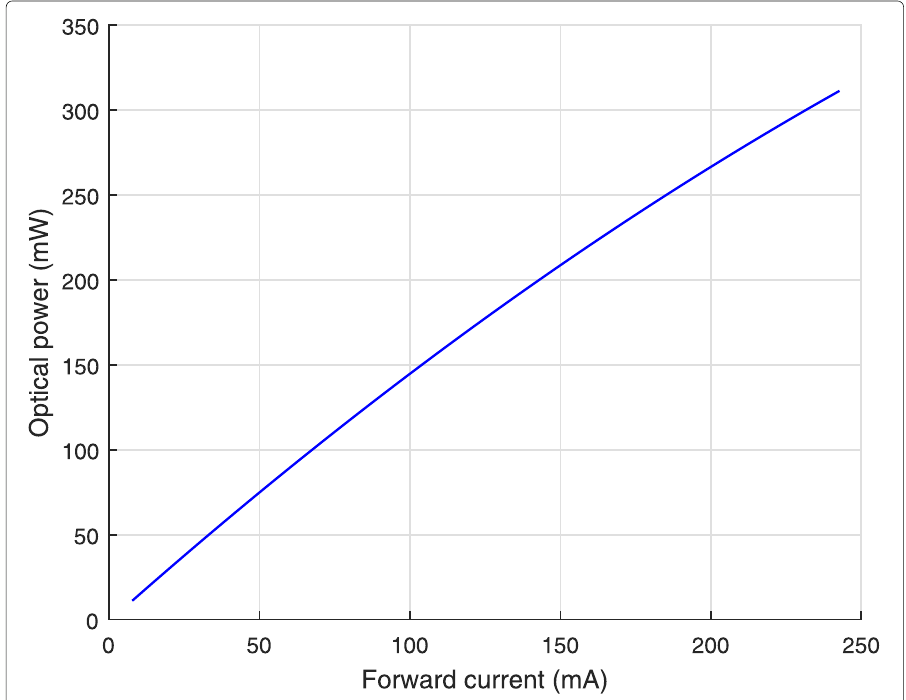
Fig. 8 Power transfer function of the LED. The variation curve of optical power versus forward